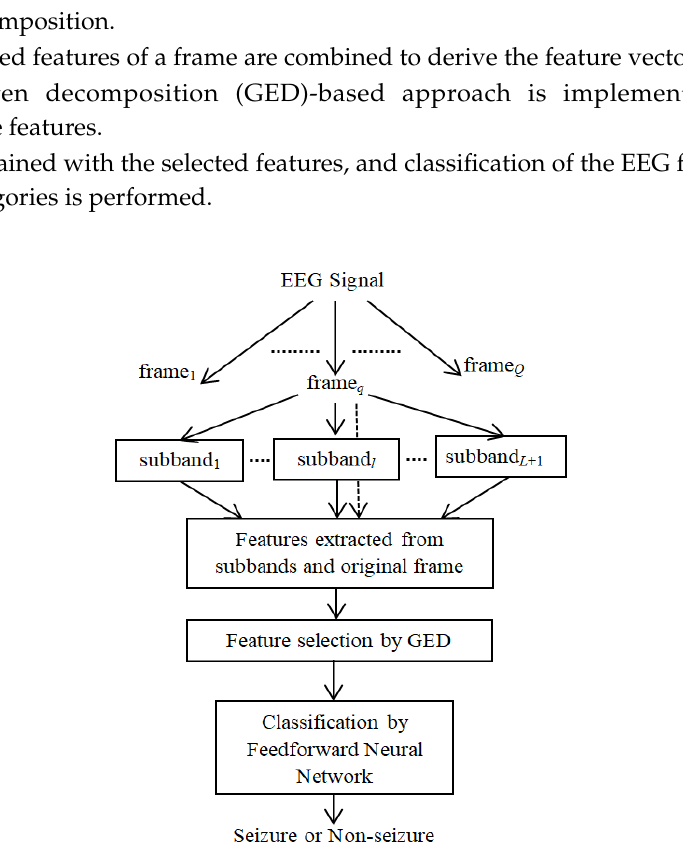
Figure 1. Electroencephalography (EEG) subframes selected from each of five sets (A–E).